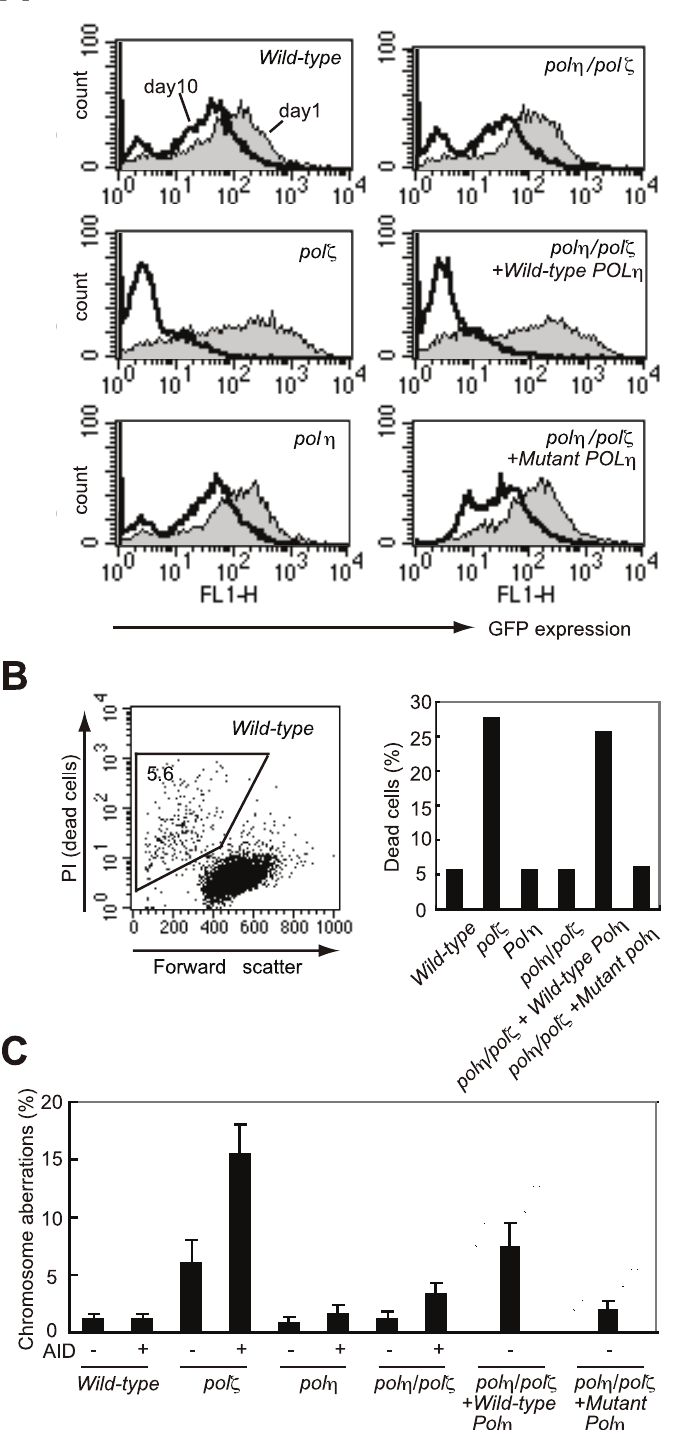
Figure 3. pol f cells, but not pol g or pol g / pol f cells, are hypersensitive to AID overexpression. (A) Reduced AID transgene expression over time in pol f cells. The expression of AID was estimated by measuring the intensity of the GFP signal. Filled and open distributions represent GFP intensity at days 1 and 10 post-infection, respectively. (B) Accumulation of dead cells in the pol f mutant population 3 days after the AID virus infection. The dot plot shows cells stained with PI. The percentage of dead cells falling into the indicated gate is shown in the histogram. (C) Chromosomal aberrations are induced by AID overexpression in pol f mutants. At day 3 post-infection, chromosomal aberrations in mitotic cells of the indicated genotype were analyzed. Fifty metaphase spreads were measured. The number of aberrations per cell 6 SE was calculated as x/N 6 ! x/N, where N and x are the numbers of cells analyzed and total aberrations, respectively.